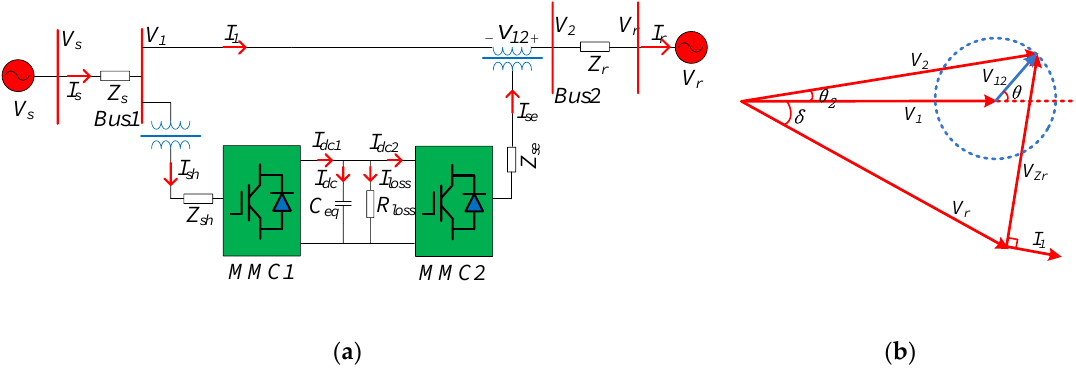
Figure 1. Schematic diagrams of MMC-based UPFC: ( a ) Structural diagram of MMC-based UPFC; ( b ) Phasor diagram of the parameters of UPFC.